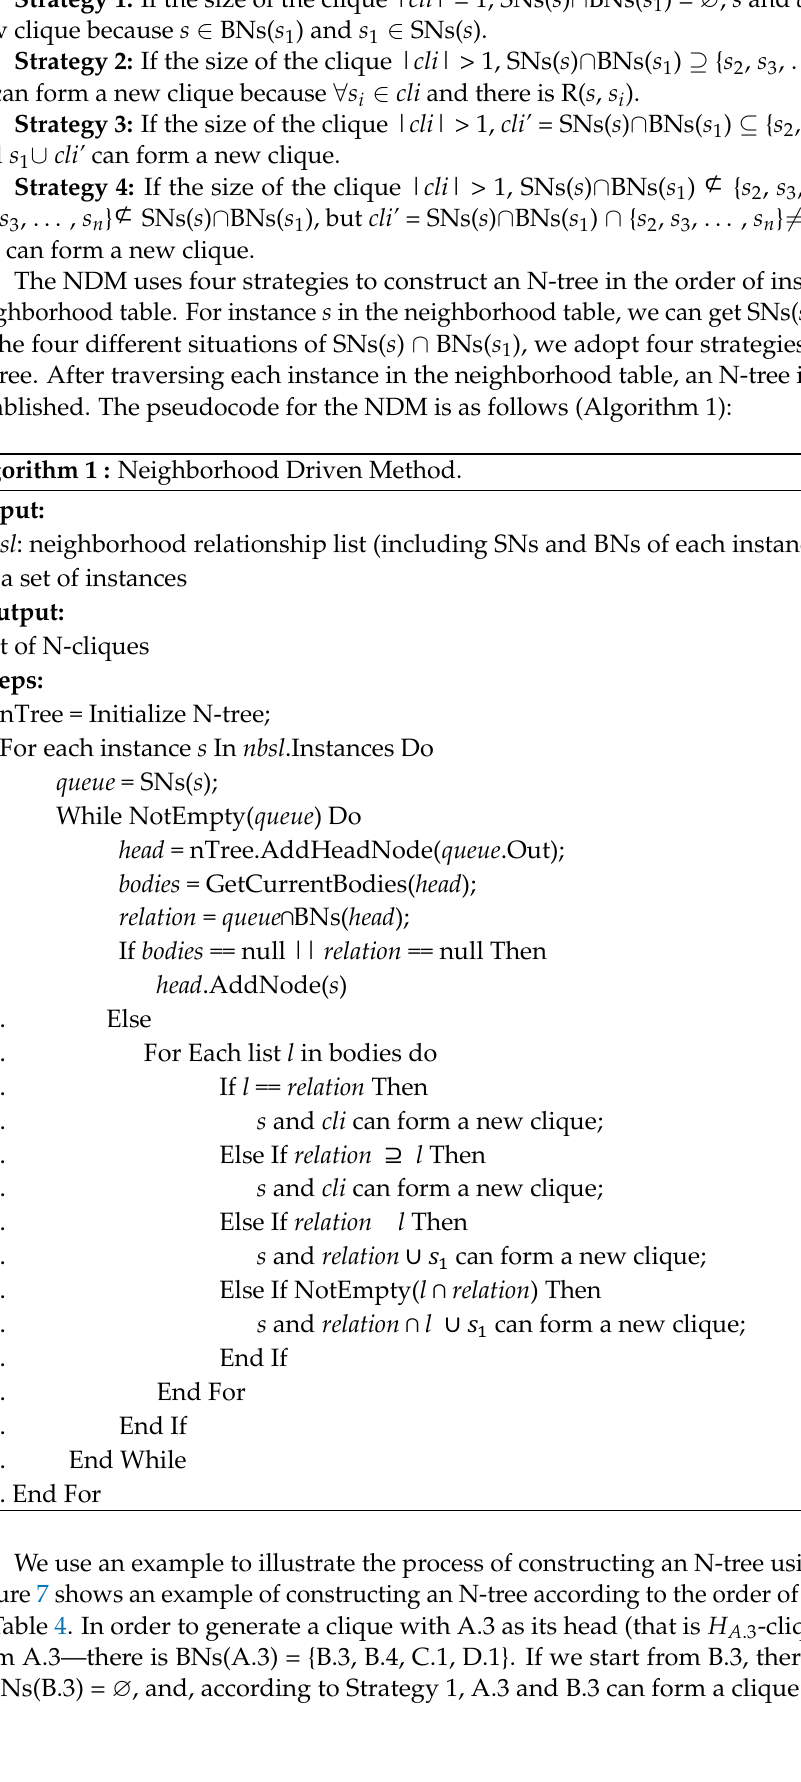
D.1 - Figure 7. An example of an N-tree constructed by the NDM. In a clique cli = {   ,   ,…,   }, for any instance for   of cli , {   ,   ,…,   } is con-